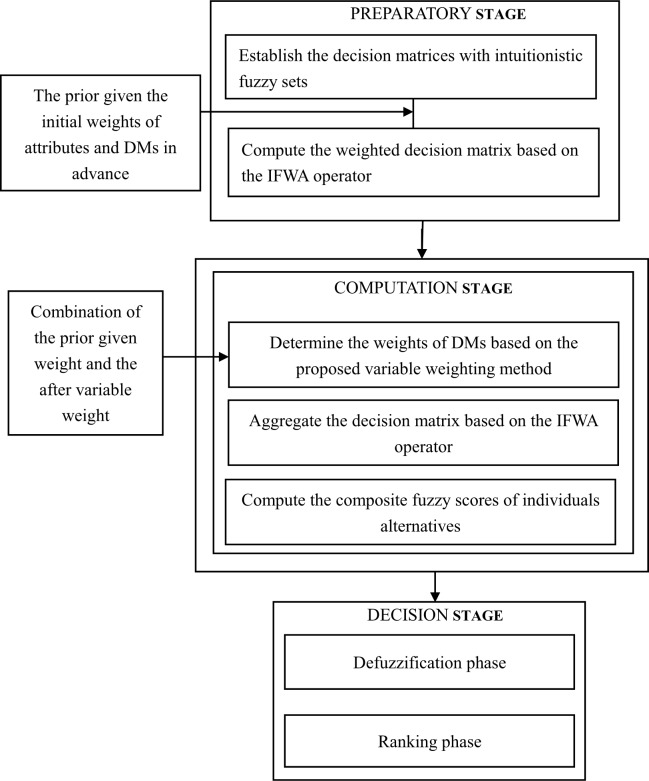
The conceptual framework of the proposed method.